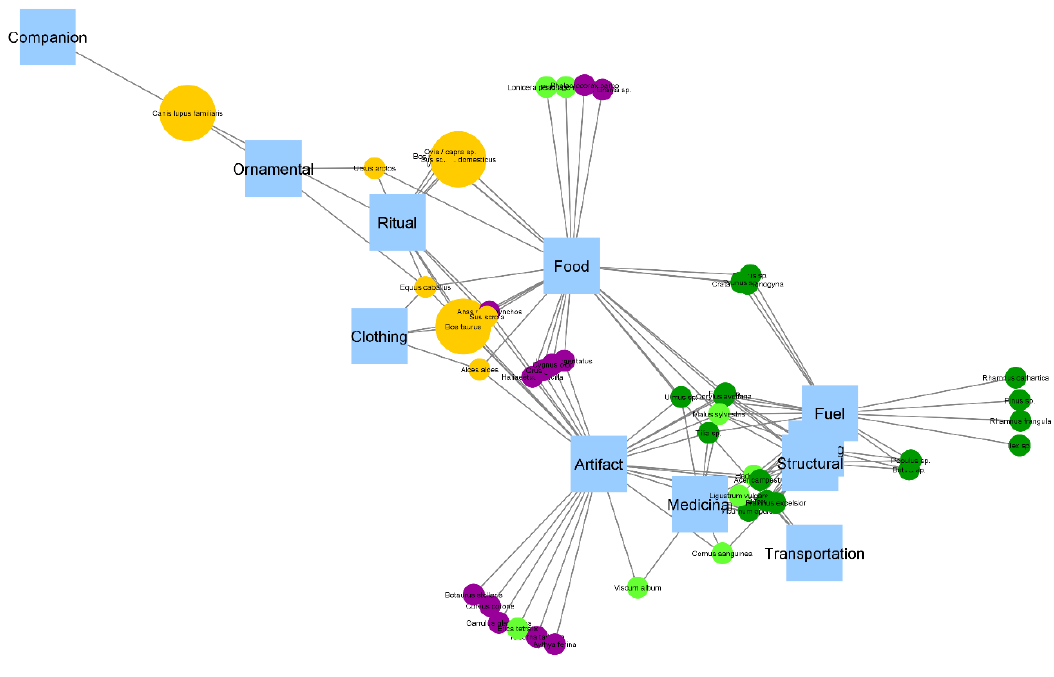
Figure 9. Visualization of network structure without domestic species.